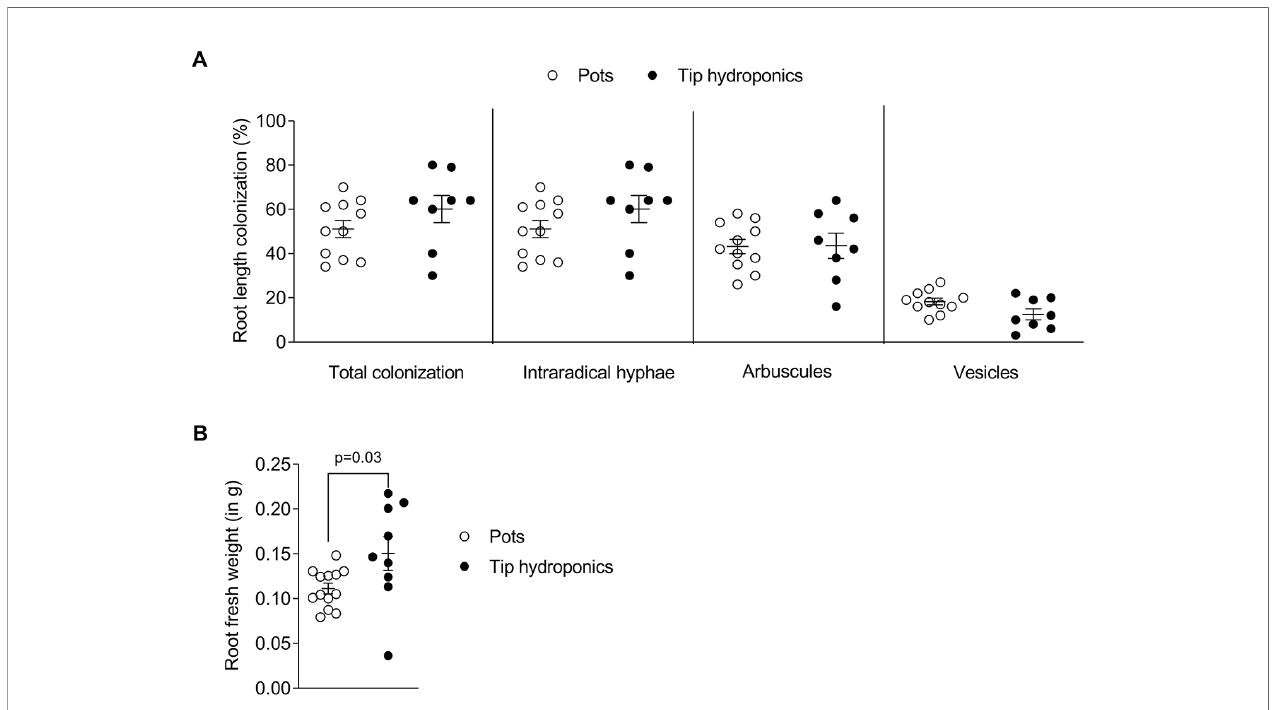
FIGURE 2 | Root length colonization after growth in sand- fi lled pots vs . tip-wick hydroponics. Comparison of (A) percent colonization of Lotus japonicus roots with Rhizophagus irregularis and (B) L. japonicus root fresh weight in sand- fi lled pot vs . tip-wick hydroponics at 4 weeks post-inoculation (wpi). Mann-Whitney tests were used for statistical comparison (n = 8 – 15 separate plants from one tip-box or two independent